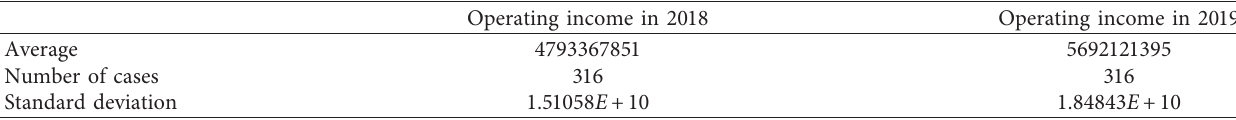
Figure 3: Changes in business tax rates of sample companies. Table 2: Descriptive statistics of each quarter of each enterprise in 2018 and 2019.